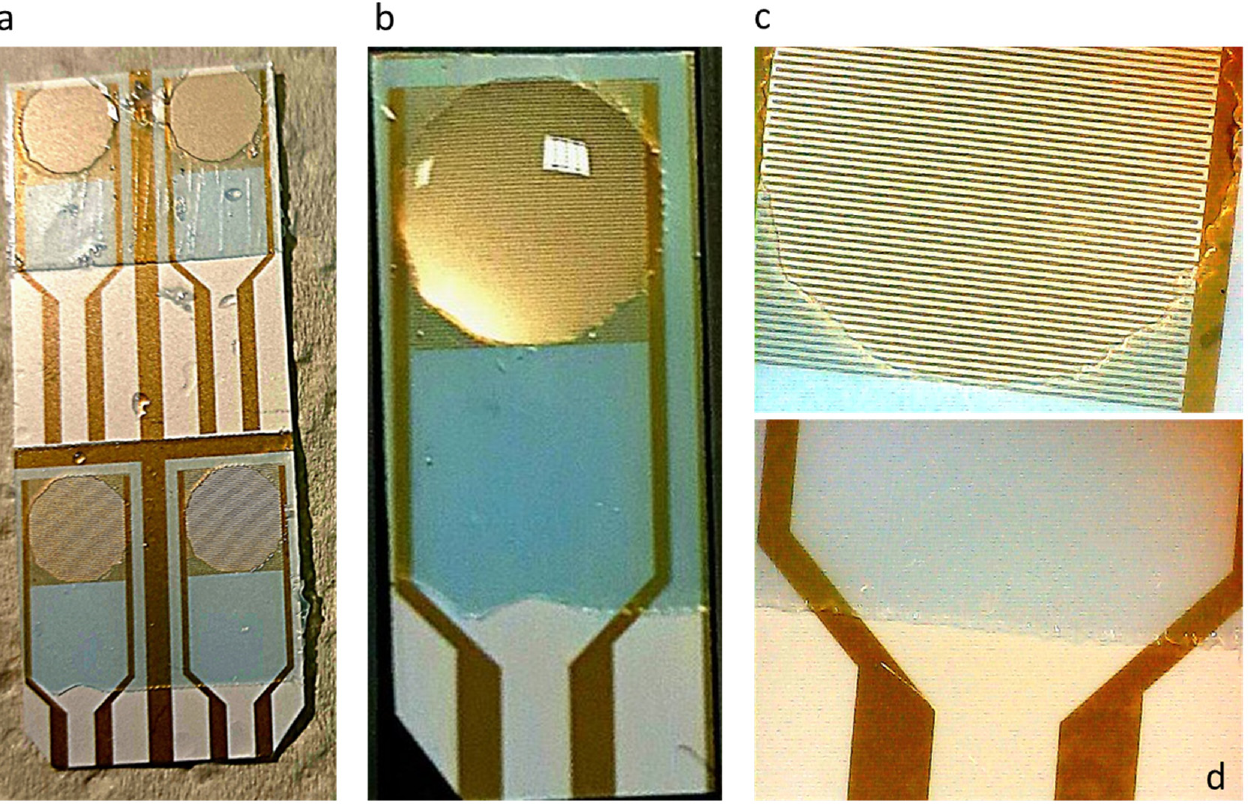
Figure 5. Patterning circular wells on capacitor sensitive area: ( a ) wells patterned on a set of capacitors; ( b ) a droplet is placed at the well; ( c ) image of the well in 20 × magnification; and ( d ) ORDYL layer does not cover the capacitor pads.